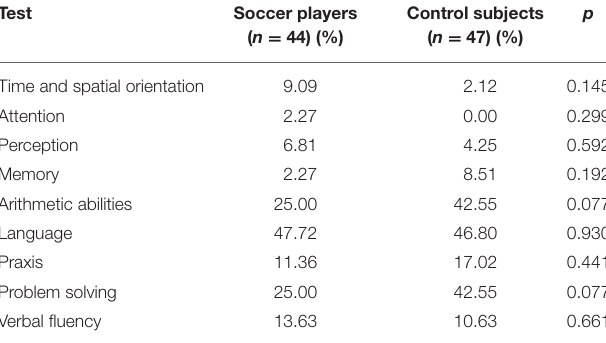
TABLE 3 | Comparison between soccer players and control subjects with regard to the rate of subjects with deficit scores on Neupsilin